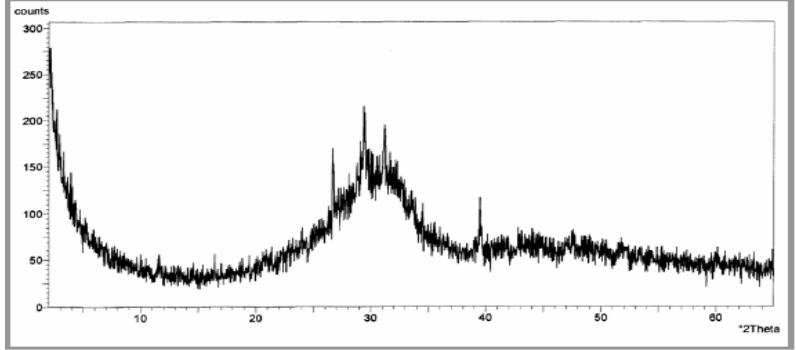
Fig. 1. Diffractogram of the